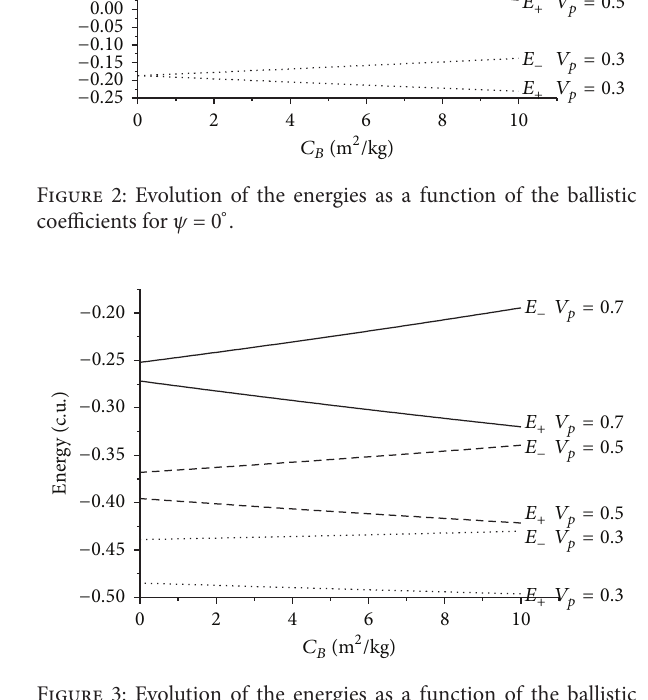
Figure 3: Evolution of the energies as a function of the ballistic coefficients for 𝜓 = 90 ∘